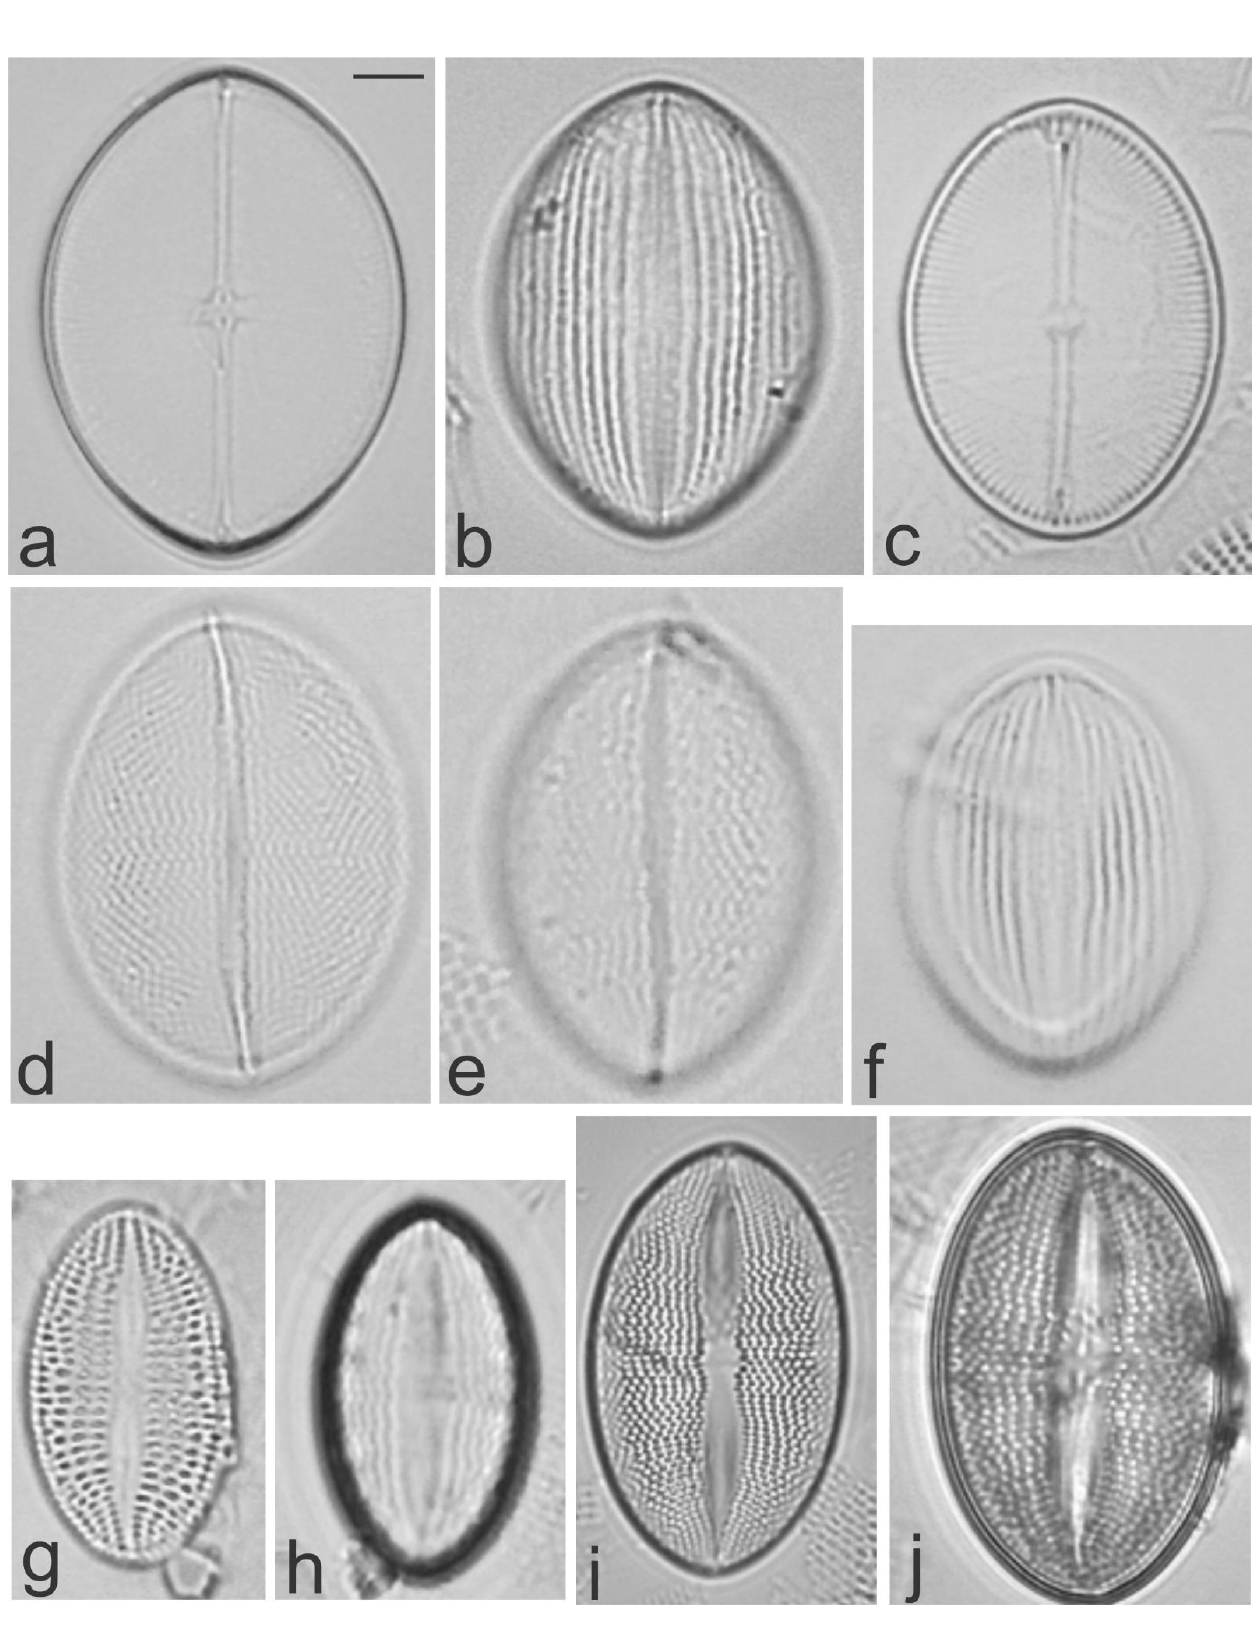
Figure 13. ( a – c , f ) Cocconeis convexa ; ( d , e , i , j ) C. dirupta ; ( g ) C. dirupta var. flexella ; ( h ) C. contermina ; Scale bar = 5 μm.